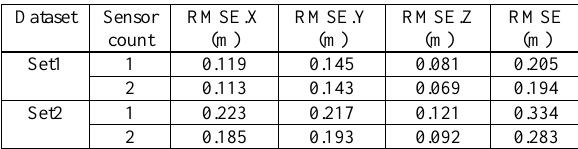
Table 1. Comparisons of the absolute trajectory error for incremental registration of RGB-D sequences with single Kinect and dual Kinects Dataset Sensor RMSE.X RMSE.Y RMSE.Z count (m) (m) (m)